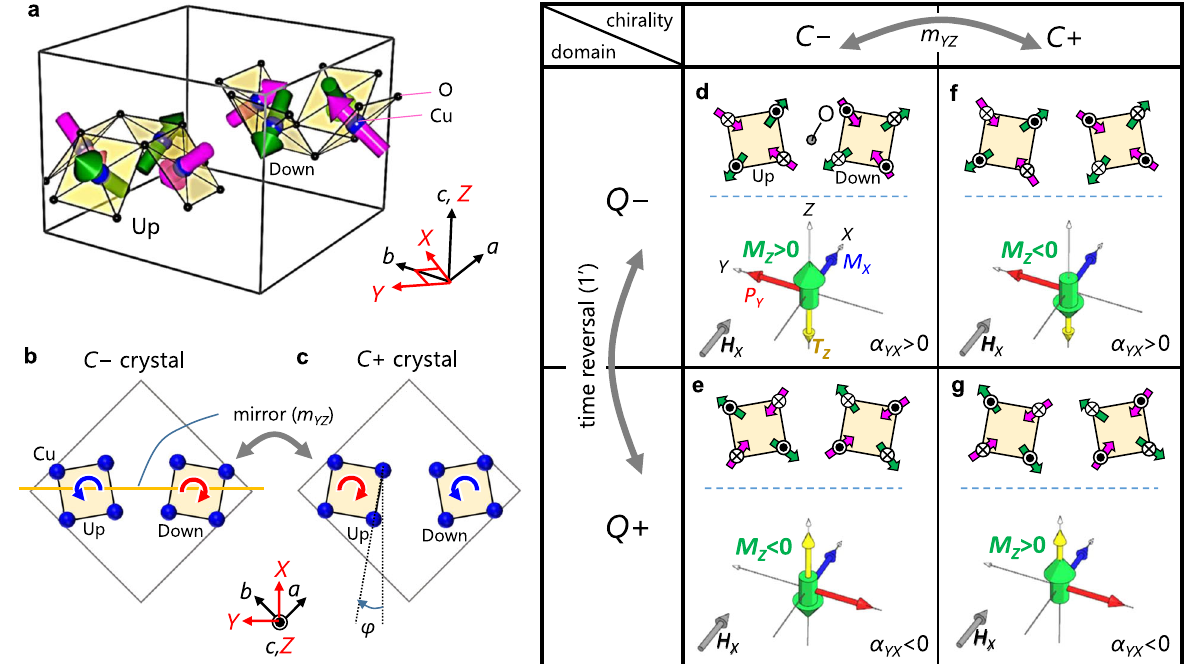
Fig. 2 Crystal structure, chirality, and magnetic domains of Pb(TiO)Cu 4 (PO 4 ) 4 . a A three-dimensional view of the crystal and magnetic structures. Pb, Ti, and P atoms are omitted for clarity. A unit cell (solid line) contains one upward and one downward Cu 4 O 12 square cupola unit each formed by four Cu 2 + ions (large blue balls) and twelve O 2 − ligands (black balls). Magenta and green arrows represent inwards and outwards Cu 2 + spins, respectively. b , c Staggered rotation of Cu 4 squares of upward [Cu 4 (U)] and downward [Cu 4 (D)] units of the C − ( b ) and C + ( c ) crystals. φ represents the rotation angle of Cu 4 (U). φ > 0 and φ < 0 correspond to C + and C − crystals, respectively. The C + and C − crystal structures are mutually converted by the mirror plane parallel to the YZ plane ( m YZ ). d – g Z -axis views of the magnetic structures of a pair of time-reversed domains Q + and Q − for each chirality. In each panel of d – g , geometrical con fi guration of M X , P Y , M Z , and T Z induced by an application of a magnetic fi eld along the X axis ( H X ) is illustrated. Here, M X and M Z are the magnetization along the X and Z axes, respectively, P Y is the electric polarization along the Y axis, and T Z is the toroidal moment along the Z axis. The sign of the linear magnetoelectric coef fi cient α YX that governs the relation of P Y and H X is also indicated.